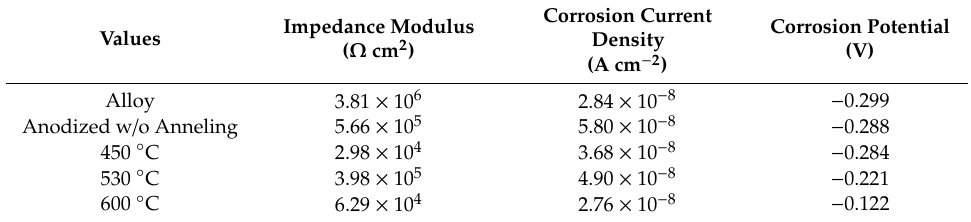
Table 1. Impedance modulus, corrosion current density and corrosion potential of the Ti–30Ta alloy, amorphous layer, annealed surface at 450 ◦ C, 530 ◦ C and 600 ◦ C.